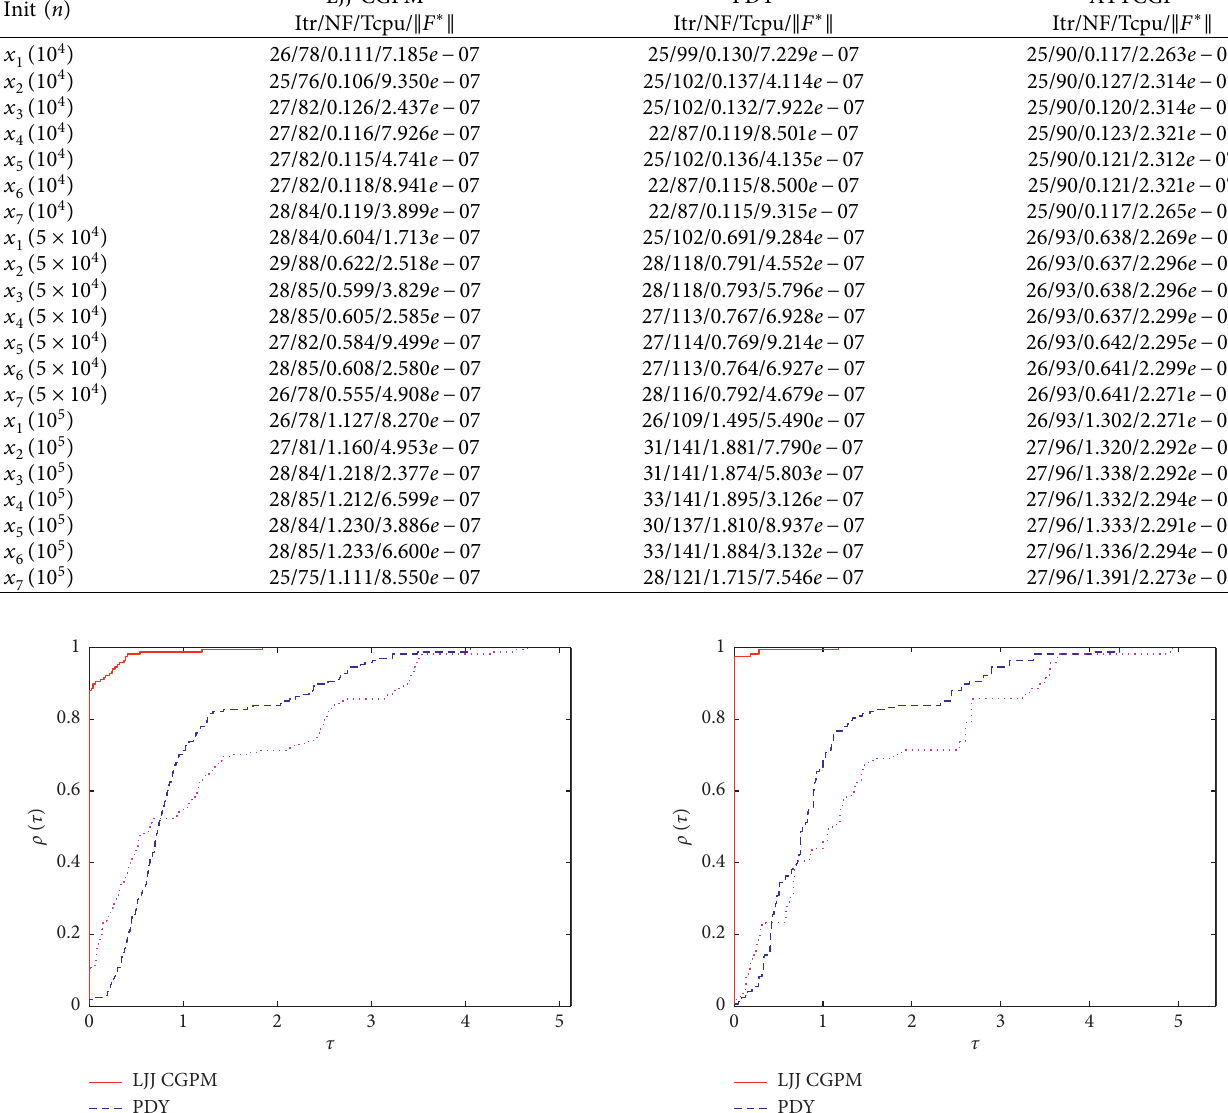
Figure 1: Performance profiles on Tcpu. Figure 2: Performance profiles on